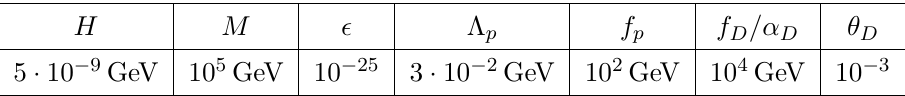
Table 1 . Benchmark point satisfying all constraints on our relaxion